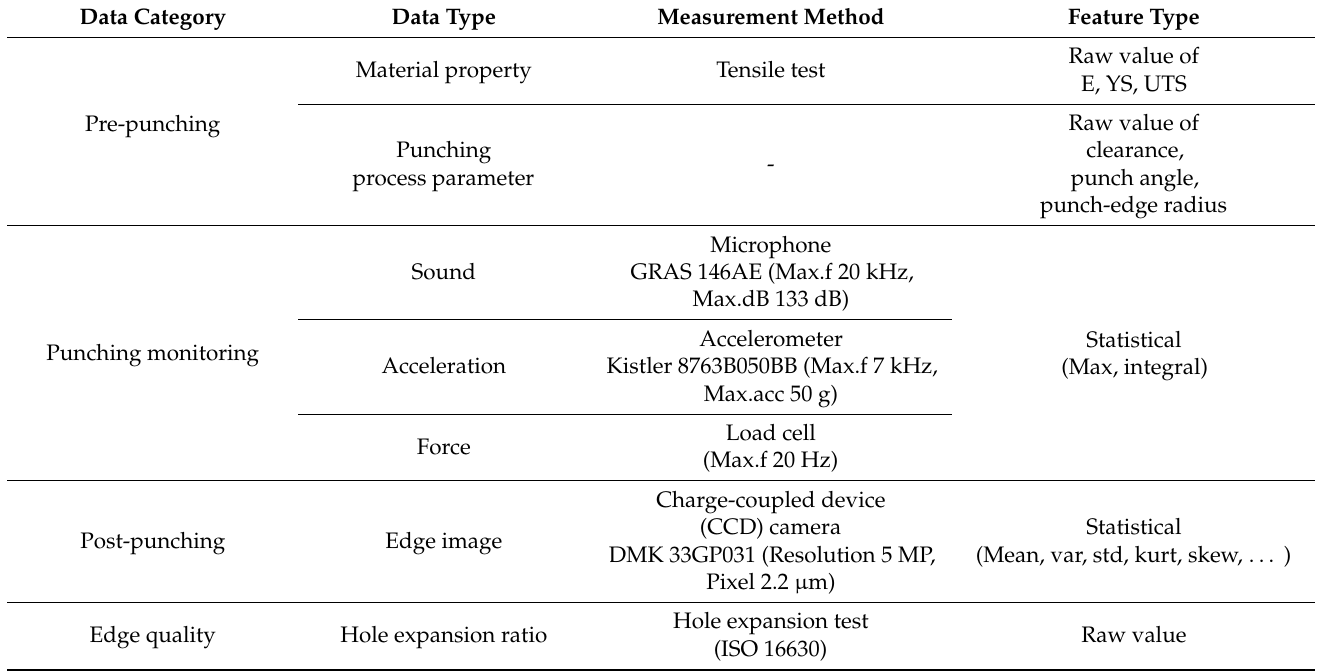
Table 1. List of input data, data measurement method, and feature type.